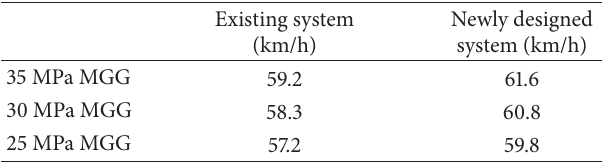
Table 9: Workable driving speeds of existing AHLS and newly designed AHLS with different actuator